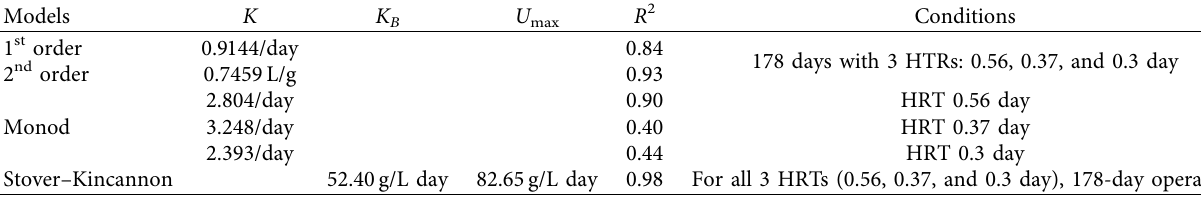
Table 2: Summary of calculated kinetic coefficients and regression coefficients.